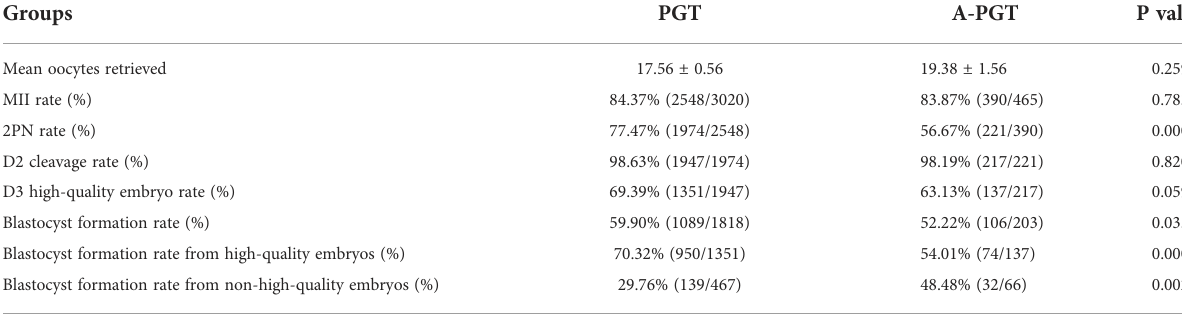
TABLE 2 Effects of A23187 activation on oocyte fertilization and embryonic development in patients undergoing PGT. Groups